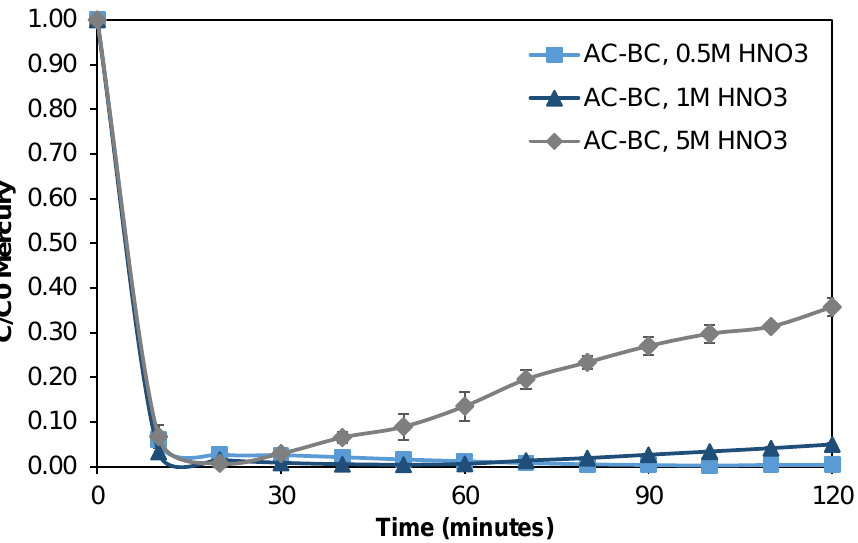
Figure 10. Mercury removal for coconut and bituminous coal-based activated carbons treated with increasing nitric acid concentrations.